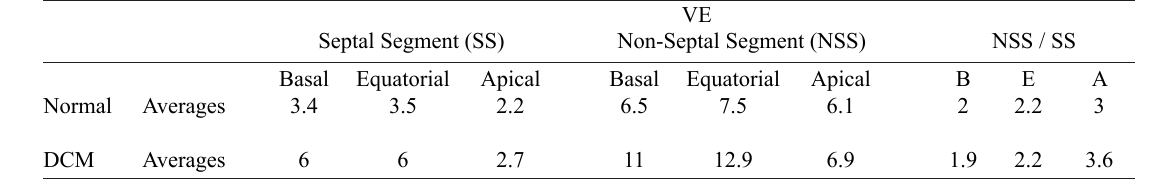
Table 1. Descriptive results (averages) for the variables measured (cm) in both groups, as well as the NSS/SS ratio of 3 regions analyzed.